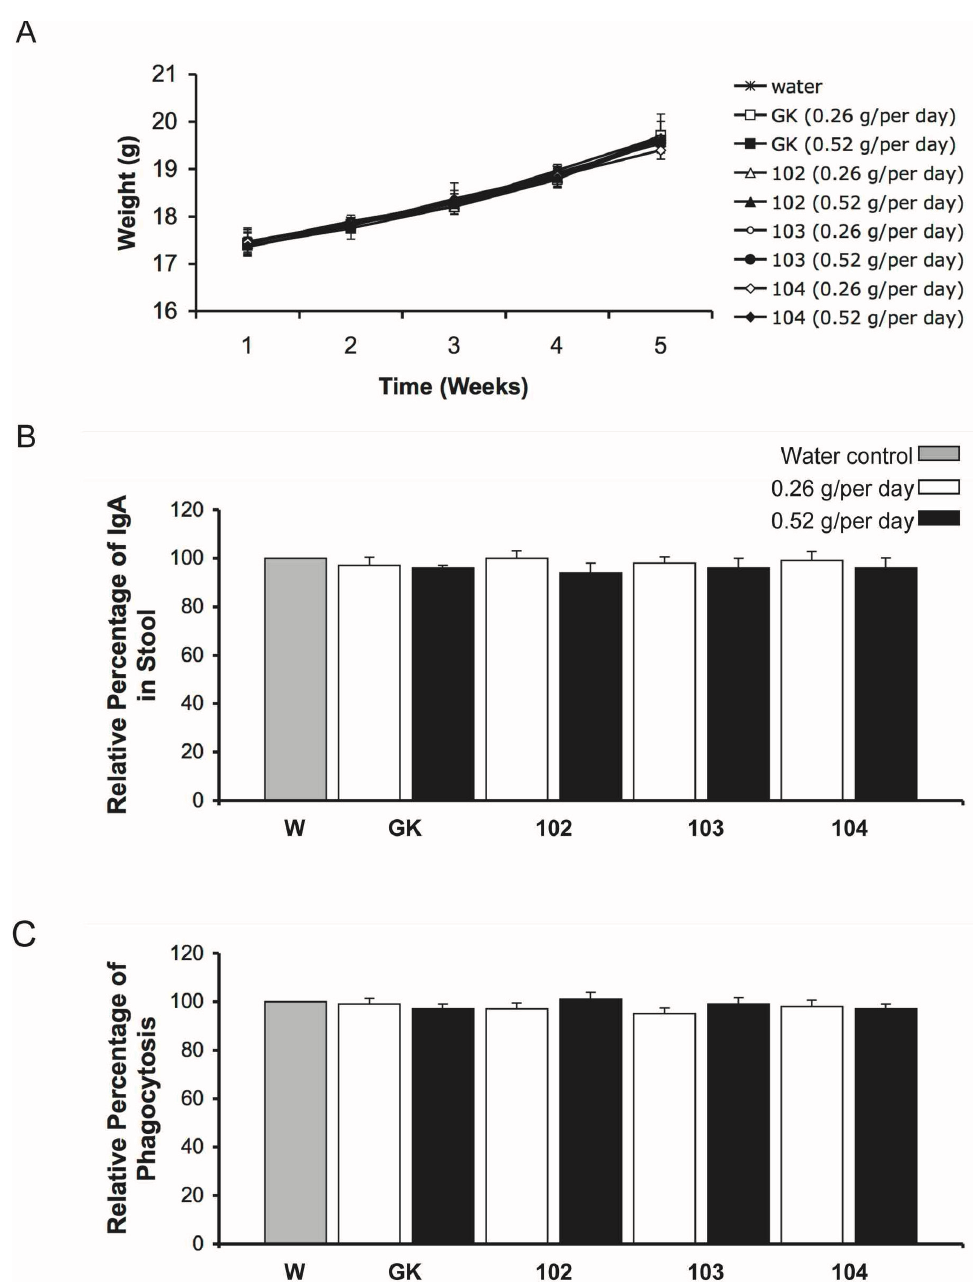
Figure 3. Growth, mucosal immunity and phagocytosis activity of mice fed ipt -transgenic broccoli. ( A ) The weight of mice fed 2 levels of broccoli florets, 0.26 and 0.52 g, over time. Data are mean ± SD ( n = 8); ( B ) Relative IgA level in mouse stools. x -axis indicates mice fed water (W) and broccoli of the parental line Green King (GK), ipt -transgenic lines 102 and 103, and inbred control line 104. The IgA level of control-water–fed mice (gray column) in stools was set to 100%. Data are mean ± SD of triplicate experiments; ( C ) Phagocytosis activity in control-water–fed mice (gray column) was set to 100%. Data are mean ± SD of triplicate experiments ( n =